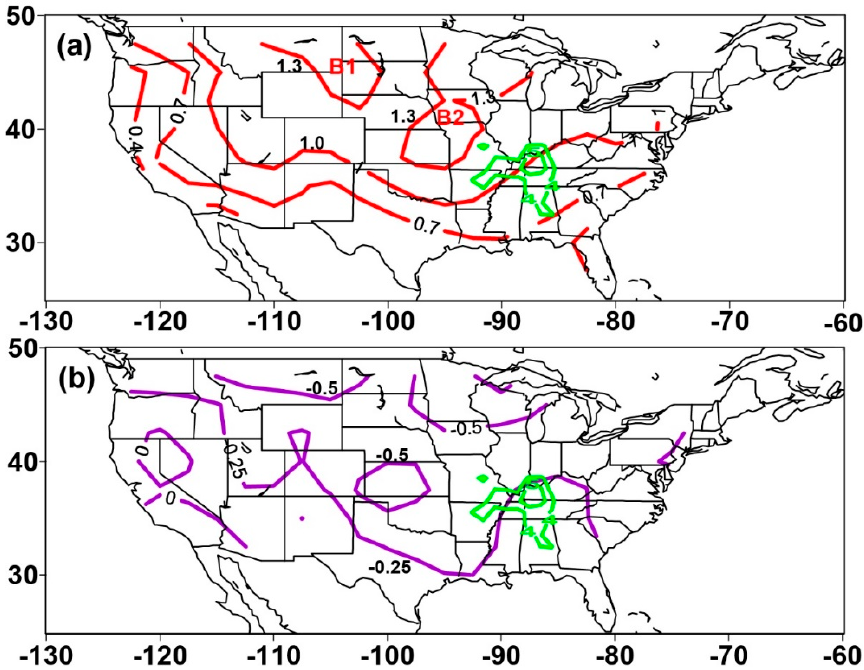
Figure 9. Composite for 10 warmest years of ( a ) surface air temperature anomaly (°C) with relative warm centers labelled B1 and B2, and ( b ) mean sea level pressure anomaly (Pa). The number of 20+ tornado days (contours) over the same period are in green colors in ( a ) and ( b ).